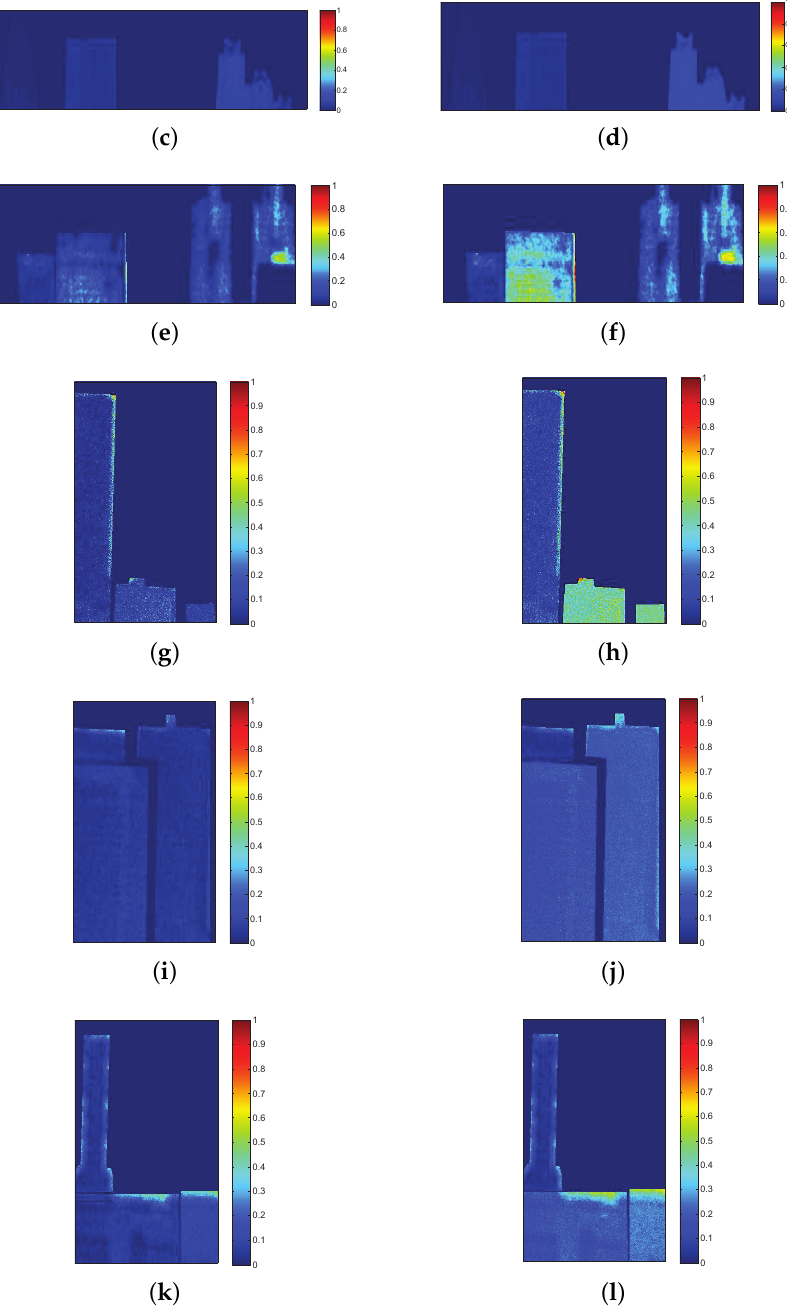
Figure 14. Error maps of 6 scenes. ( a ) Error map of our method for scene 1. ( b ) Error map of comparison method for scene 1. ( c ) Error map of our method for scene 2. ( d ) Error map of comparison method for scene 2. ( e ) Error map of our method for scene 3. ( f ) Error map of comparison method for scene 3. ( g ) Error map of our method for scene 4. ( h ) Error map of comparison method for scene 4. ( i ) Error map of our method for scene 5. ( j ) Error map of comparison method for scene 5. ( k ) Error map of our method for scene 6. ( l ) Error map of comparison method for scene